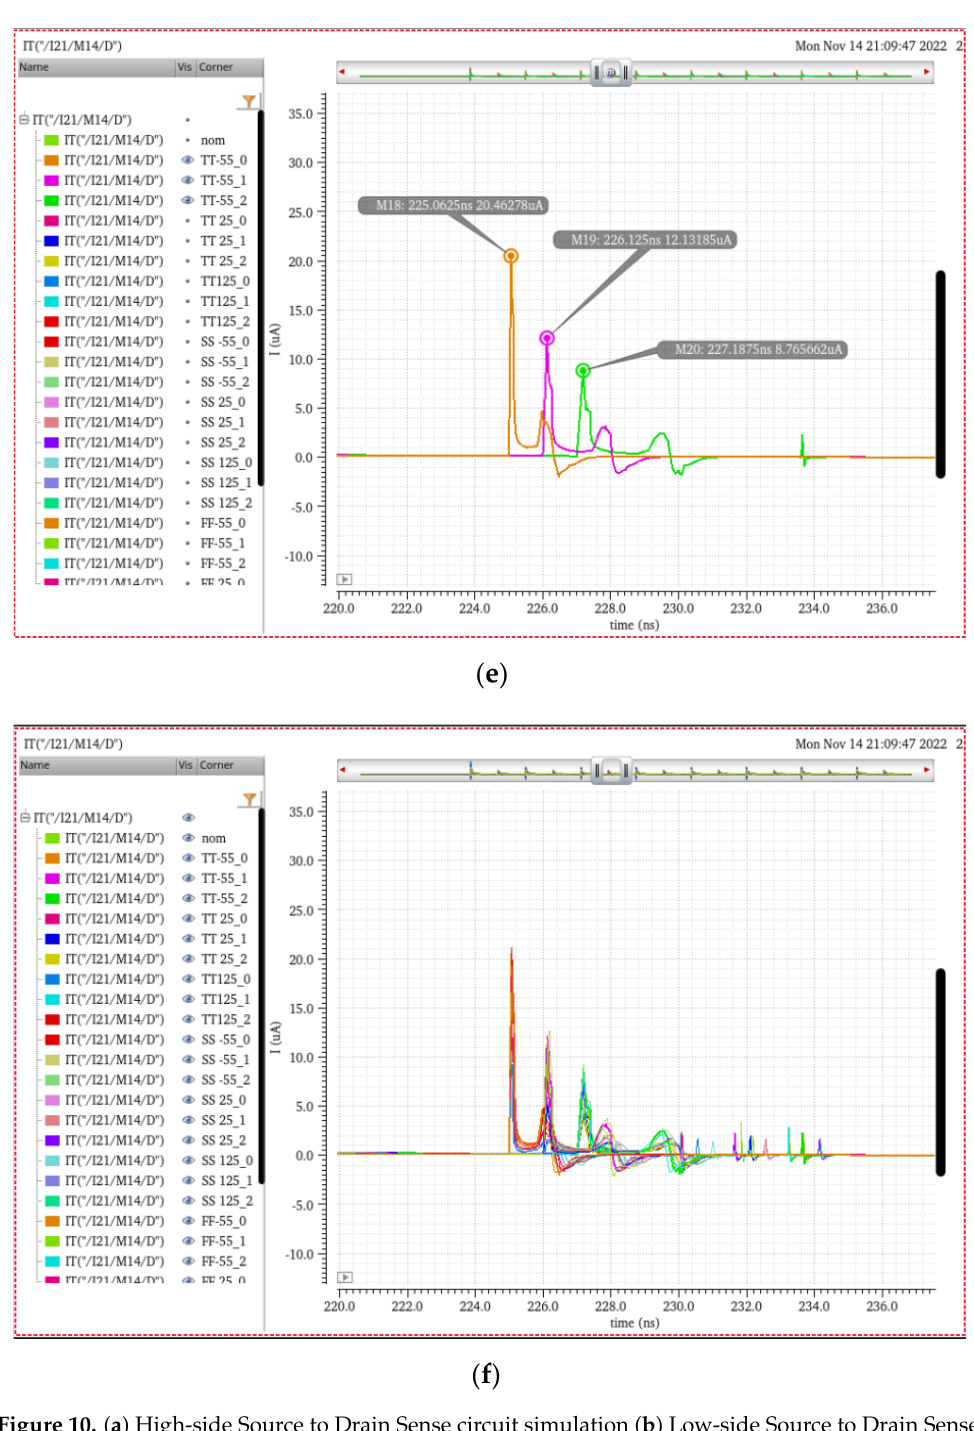
Figure 10. ( a ) High-side Source to Drain Sense circuit simulation ( b ) Low-side Source to Drain Sense circuit simulation ( c ) High-side Current Sense circuit simulation in TT -55 °C ( d ) High-side Current Sense circuit simulation in TT SS FF ( e ) Low-side Current Sense circuit simulation in TT -55 °C ( f ) Low-side Current Sense circuit simulation in TT SS FF.